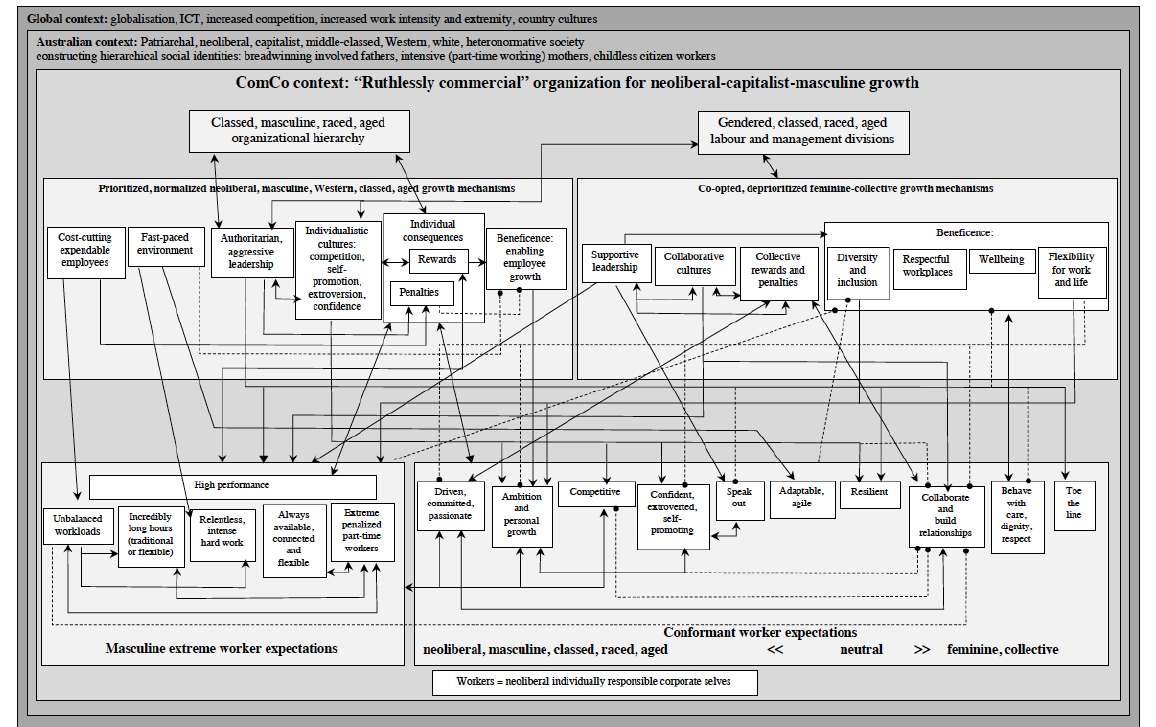
Figure 1. ComCo’s multilevel, diversified inequality regimes. Solid line with arrow/s indicates facilitation in direction/s of arrow/s; broken line indicates barrier in direction ending with circle; lines ending at border of shaded or white box indicate influence on all processes inside box; lines beginning or ending at border of white box indicate influence by or on process inside box.